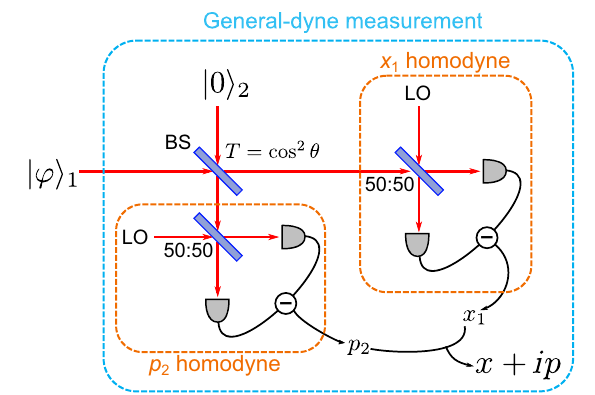
FIG. 7. Construction of a general-dyne measurement using two balanced homodyne detectors and one ancillary vacuum state. The overall measurement protocol projects the input state | ϕ (cid:5) to a measurement basis spanned by displaced squeezed 1 states {| φ ξ ( x + ip ) (cid:5)} . The outcome of the general-dyne measure- ment is related to the outcomes of the homodyne detectors via x + ip = sec θ x 1 + i csc θ p 2 . The level of squeezing of the mea- surement basis ξ = tan θ can be set via the choice of the beam splitter (BS) transmissivity T = cos 2 θ . LO, local oscillator for a homodyne